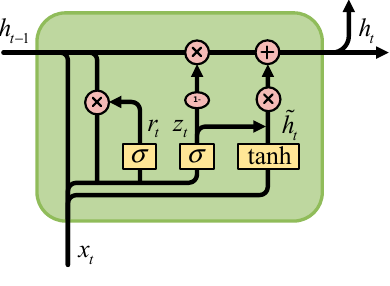
Figure 1. Gated Recurrent Unit.